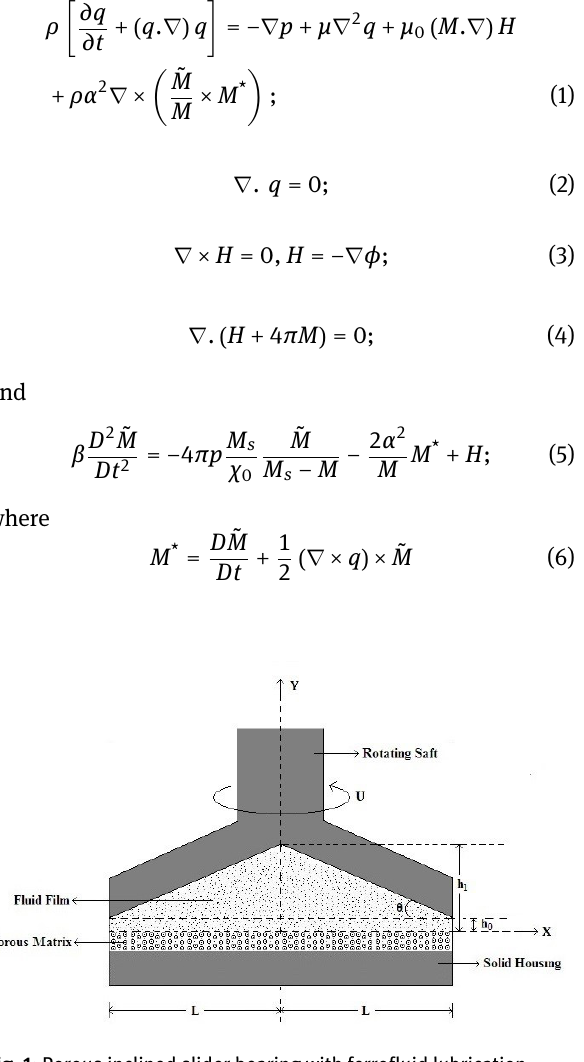
Fig. 1: Porous inclined slider bearing with ferrofluid